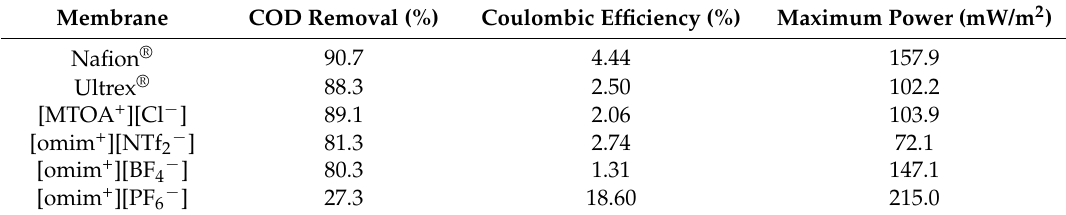
Table 2. Comparison of MFC with different ionic liquids membranes and Nafion and Ultrex membrane as reference membranes, where COD, [MTOA + ][Cl − ], 1-[omim + ][NTf 2 − ], [omim + ][BF 4 − ], and [omim + ][PF 6 − ] are chemical oxygen demand, methyl trioctyl ammonium chloride, Octyl-3-methylimidazolium bis{(trifluoromethyl)sulfonyl}imide, 1-Octyl-3-methylimidazolium tetrafluoroborate, and 1-Octyl-3- methylimidazolium hexafluorophosphate,